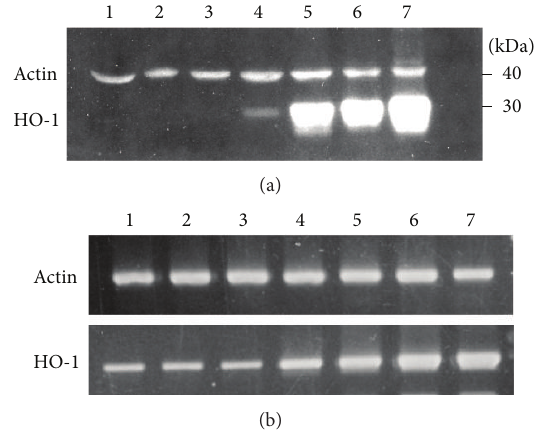
Figure 2: Induction of HO-1 by ZnPP in PC-3 for various lengths of time. PC-3 cells were treated with 10 𝜇 M ZnPP for 0.5, 1, 4, 16, 24, and 48h (lanes 2, 3, 4, 5, 6, and 7, resp.). Control cells were treated with equal amount of DMSO for 48h (lane 1). (a) Western blot analysiswasdoneasdescribedinSection 2,usingspecificantibodies against 𝛽 -actin and HO-1. Immunoreactive protein bands detected by WesternDot 625 appeared as fluorescent bands. (b) RT-PCR analysis using gene-specific primers. PCR fragments were visualized by ethidium bromide staining.